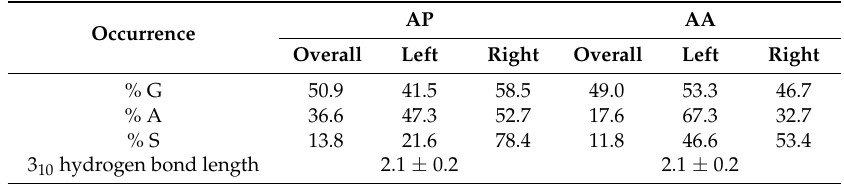
Table 4. 3 10 -helices in the 300 K replicas. %G, %A, and %S indicate the occurrence of Gly, Ala, or Ser, respectively, given as a percentage of all residues in 3 10 -helices. The average length of hydrogen bonds in the 3 10 -helices (in Å) is also shown. AP AA Occurrence Overall Left Right Overall